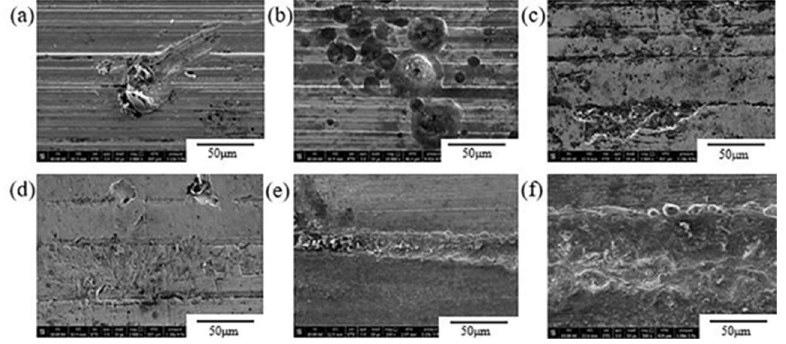
Figure 15. SEM photograph of gear tooth surface ( a ) abrasive particles embedded in the tooth surface, ( b ) pittings on the gear surface, ( c ) many pitting pits were generated at the crack edge, ( d ) plastic flow between two grooves, ( e ) serious grooves on the gear surface, ( f ) groove enlarged image.